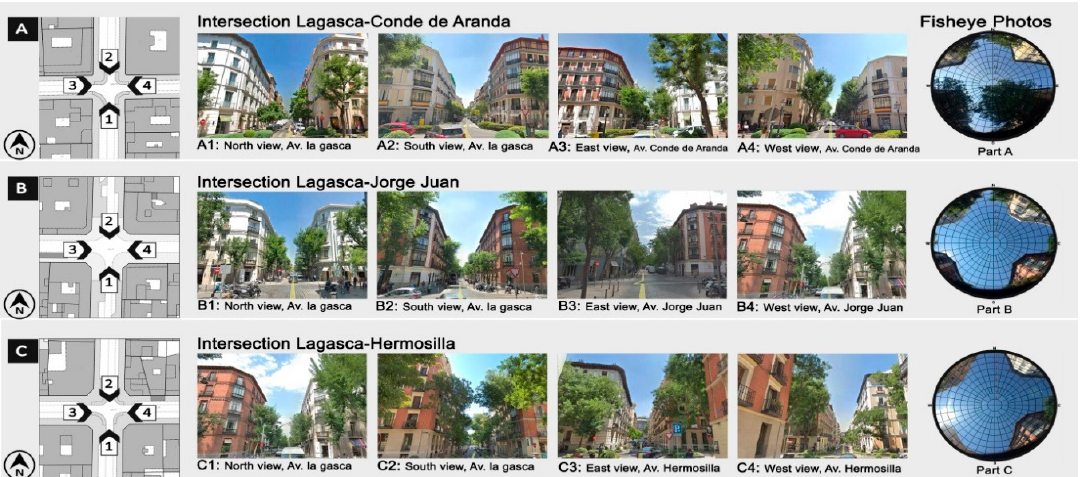
Figure 3. Street view of the three intersections (A, B and C) as well as fisheye shots. Table 1. The geometric configuration of the intersections and street trees properties in three investigated